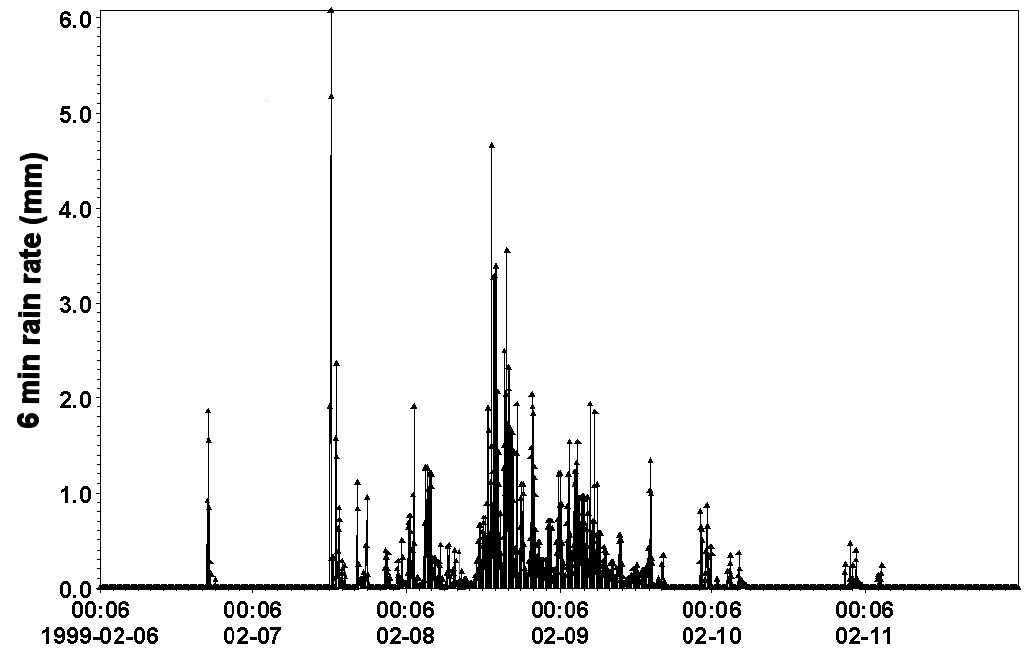
Figure 3. Plot showing the six minute rainfall pluviograph between 12:06 AM 6 February and 12:00 AM 12 February 1999 at Cressbrook Dam, Queensland, Australia (source: BOM